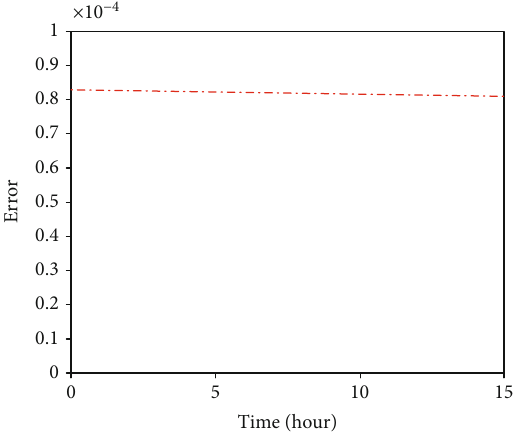
Figure 16: The error between the two methods in a fl ight duration.